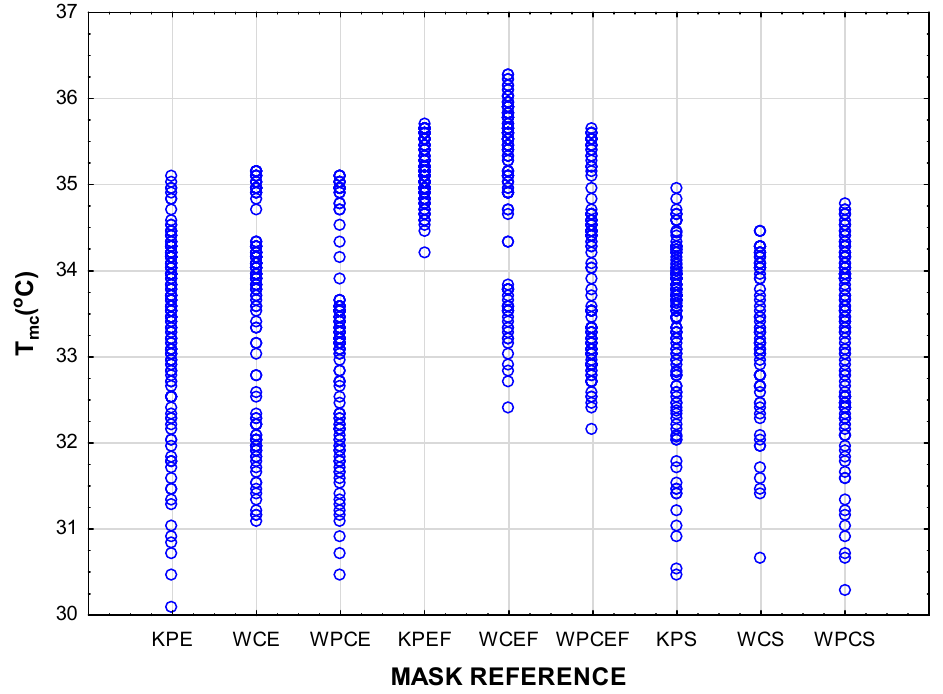
Figure 7. Scatterplot depicting individual values for the T mc in all the mask designs.